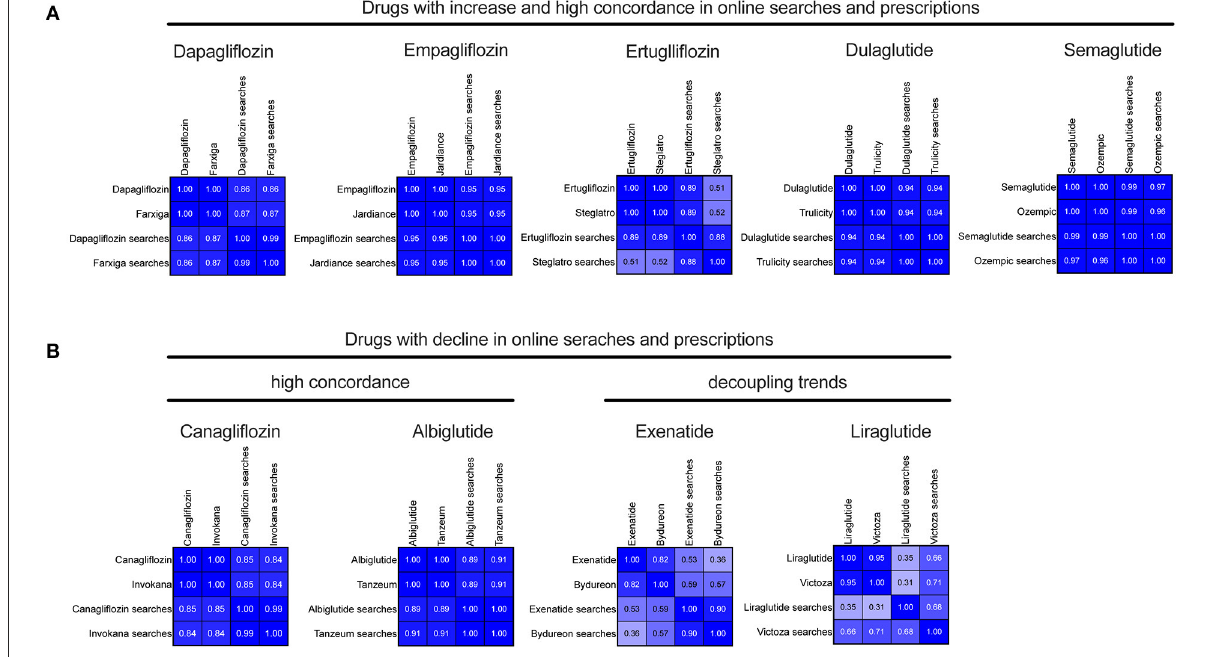
FIGURE3 Correlation analyses between prescriptions and online searches for SGLT2i and GLP-1 RA. Correlation matrices for (A) drugs and corresponding brand names with increasing trends in both prescriptions and online searches (indicated by “searches”). (B) Drugs and corresponding brand names with overall decreasing trends in both prescriptions and online searches (indicated by “searches”). Spearman’s correlation coefficients were calculated for the period between 2016 and